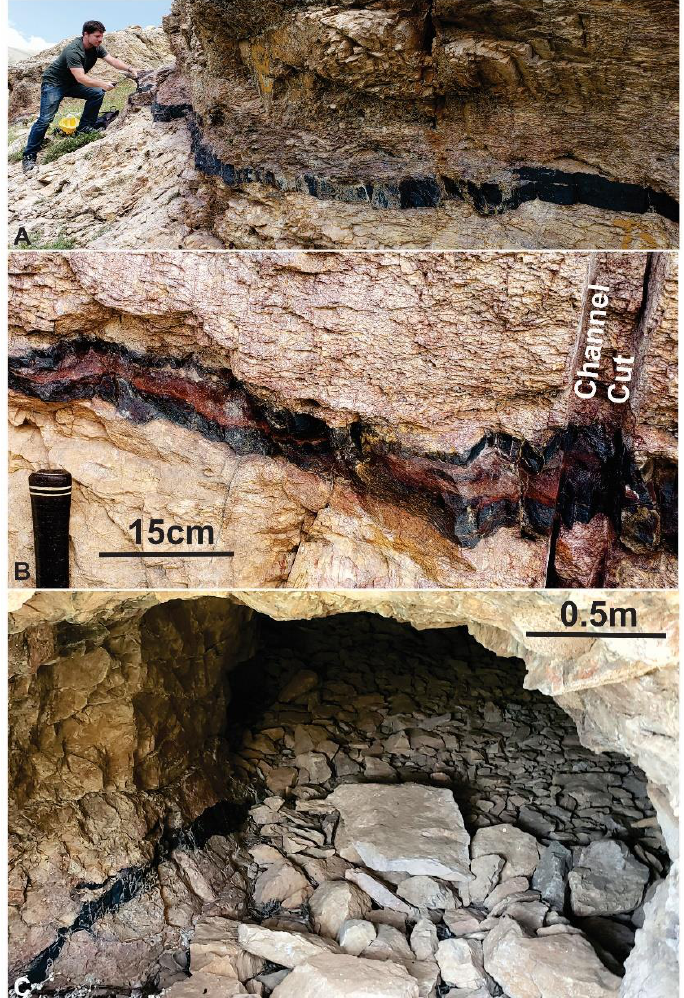
Figure 4 . In situ outcroppings of hematite-quartz veins. ( A ) Vein immediately above the main mine entrance; ( B ) close-up of A showing channel sample from prior analysis; ( C ) hematite-quartz vein exposed in wall of collapsed mine entrance.